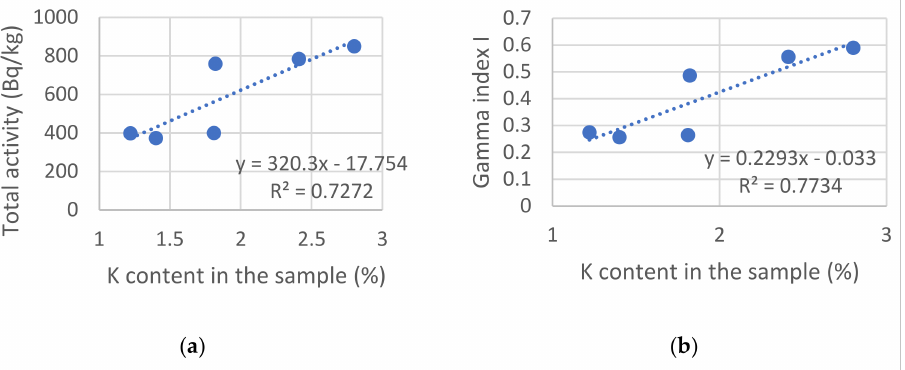
Figure 7. Correlation between the potassium content and the radiological parameters: ( a ) total activity of radionuclides; ( b ) gamma index of radionuclides.